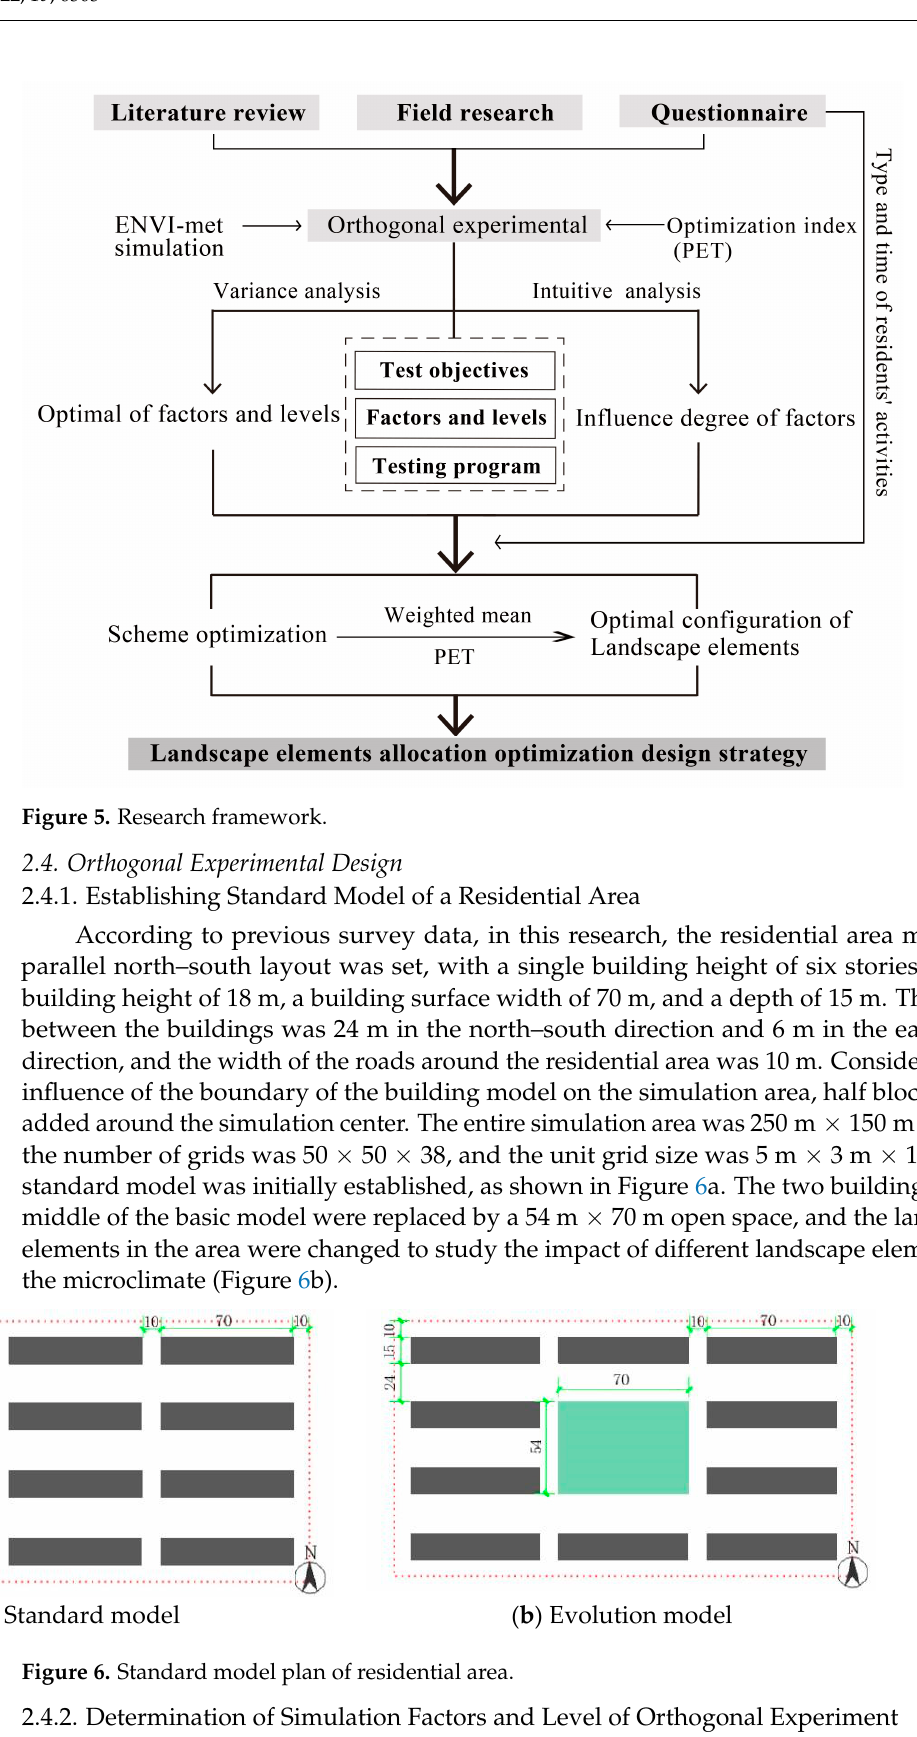
( b ) Shaded space Figure 3. Outdoor environmental conditions of the Lhasa residential area. ( a ) Resident’s behavior habits ( b ) Activity time in summer ( c ) Activity time in winter Figure 4. Characteristics of residents’ behavior habits. 2.3. Research Framework The research framework of this study is shown in Figure 5: (1) The landscape ele- ments model of the residential area was grouped with the orthogonal design method to determine the experimental scheme. (2) ENVI-met, a three-dimensional urban microcli- mate simulation software jointly developed by Michael Bruse and Heriberfleet of Bochum University in Germany, was used for numerical simulation. This study used ENVI-met version v4.4.3 (Michael Bruse, Mainz, Germany) for the calculation to study the influence